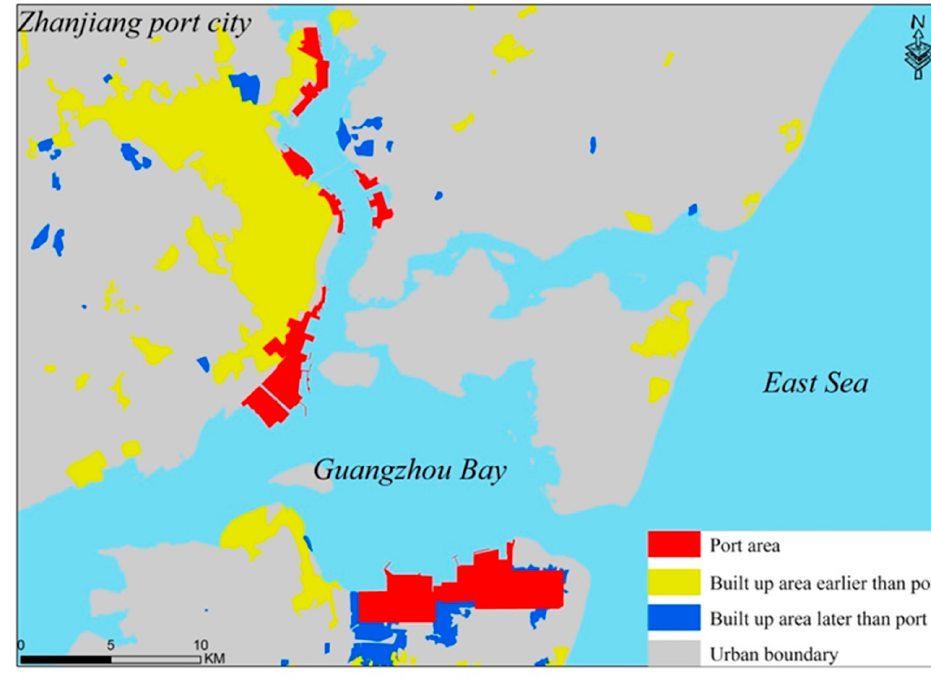
Figure 5. Spatial change of coastal port–city interface (source: drawn by author). Table 3. Area of estuarine and coastal port cities.